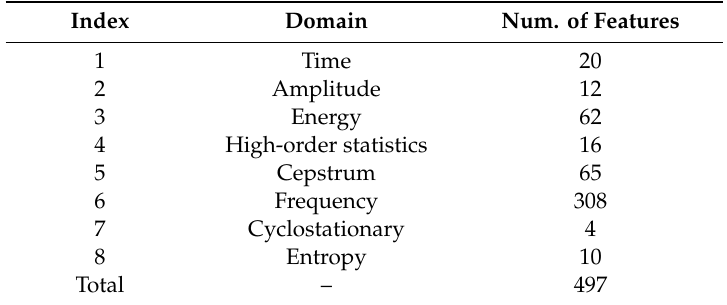
Table 1. Summary of the numbers of features extracted from eight